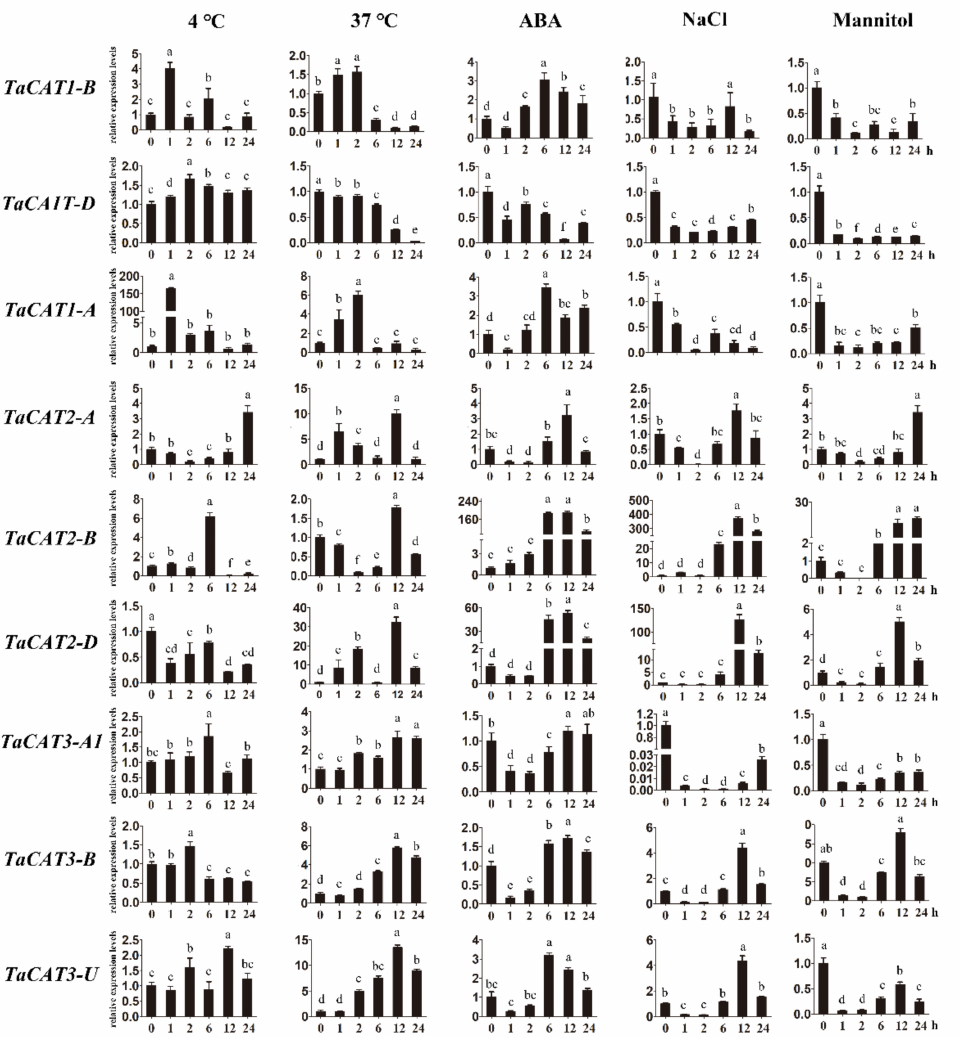
Figure 7. Expression analysis of TaCAT genes under different treatments by qRT-PCR. Relative expression levels of TaCATs in response to cold, heat, ABA, NaCl, and mannitol treatments for 0 h, 1 h, 2 h, 6 h, 12 h, and 24 h in the leaves at the three-leaf stage. Data were normalized with β -actin gene, and vertical bars indicate standard deviation error. Different letters indicate significant differences at p < 0.05 according to one-way ANOVA and post-hoc Tukey’s